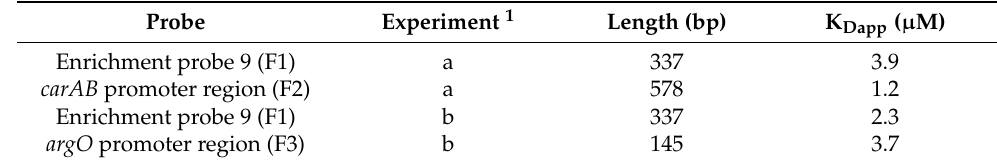
Table 2. Apparent dissociation constants (K Dapp ) of Sul12a binding in the competition experiment (Figure 6). Fitted binding curves are shown in (Supplementary Figure